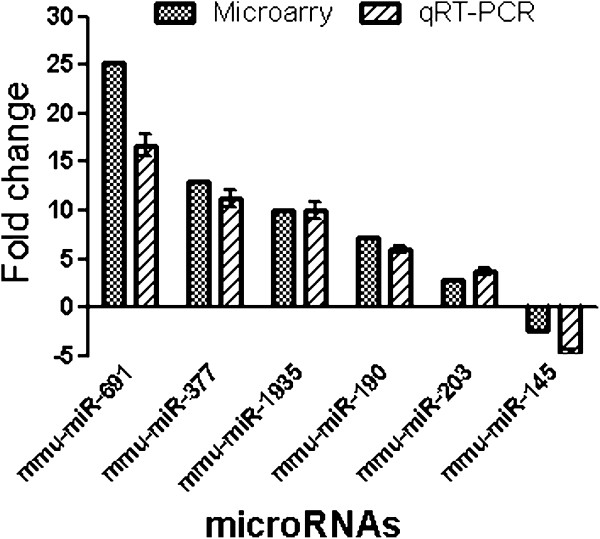
Verification of differentially expressed miRNAs by qRT-PCR. Six differentially expressed miRNAs were selected from miRNA microarray datasets and examined by qRT-PCR. The fold change from the qRT-PCR was determined using the 2-ΔΔCt method and all miRNA expression values were normalized against the U6 endogenous control. Data from qRT-PCR are shown as mean ± standard deviation (SD) of one representative experiment. Similar results were obtained in three independent experiments.